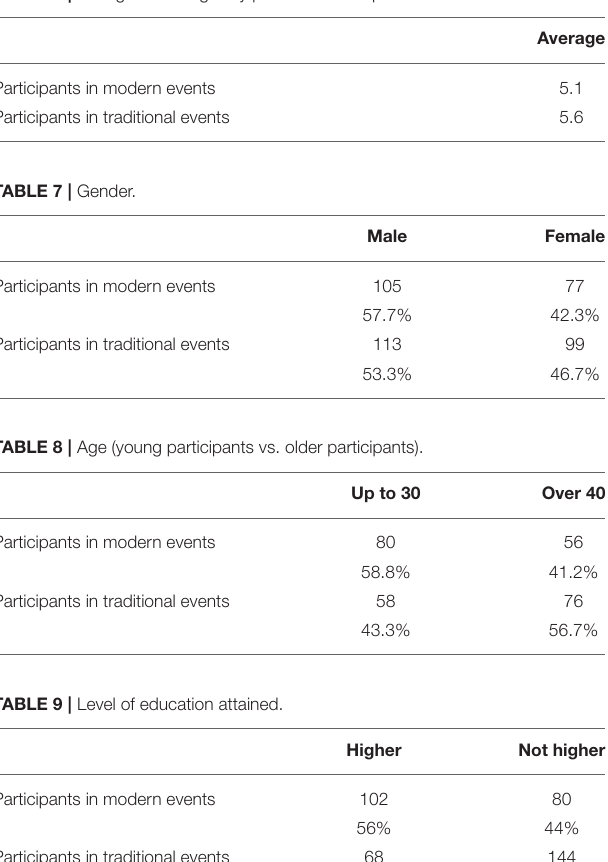
TABLE 6 | Willingness to regularly practice water sports after events.